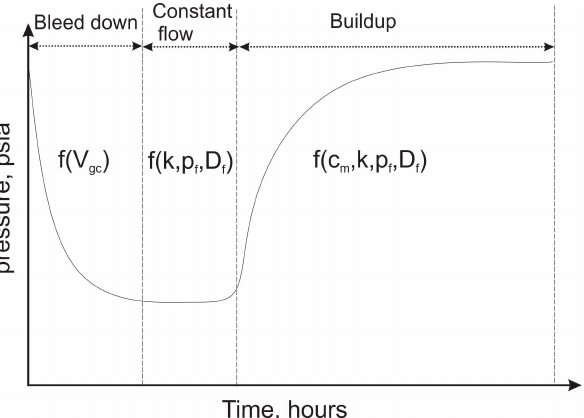
Figure 4. Different stages of the B-B test with the important parameters affecting each stage (adapted with permission from Kazemi et. al, SPE, 2014 [14]).